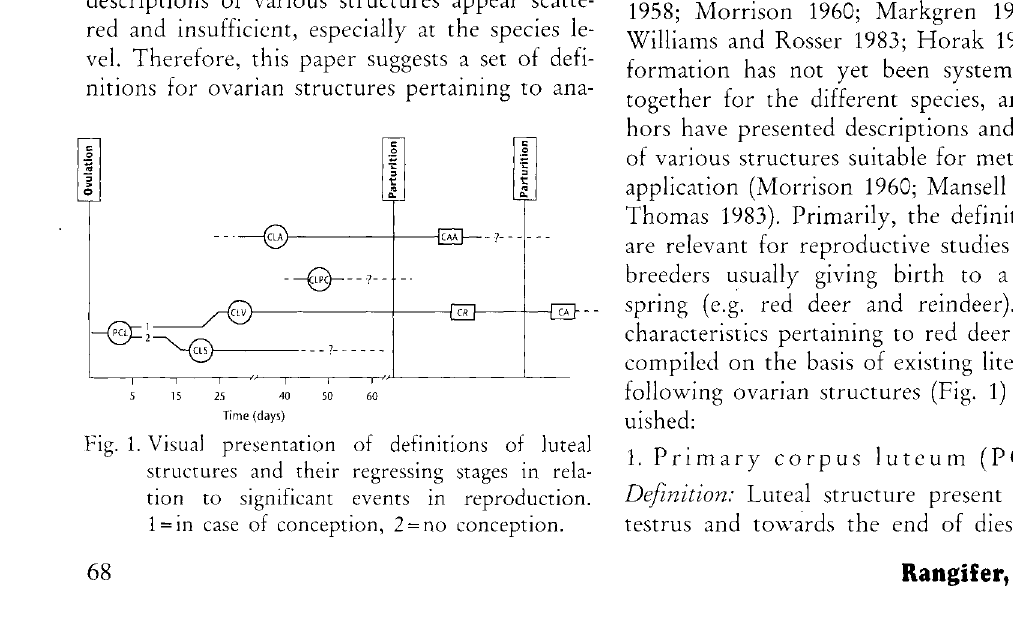
Fig. 1. Visual presentation of definitions of luteal structures and their regressing stages in rela tion to significant events in